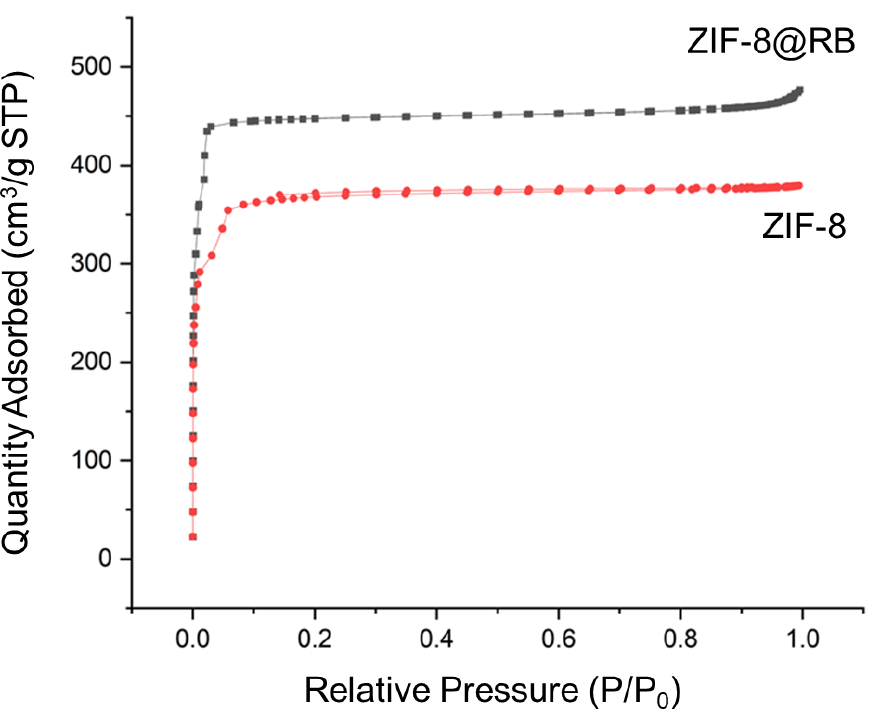
Figure 5. Nitrogen adsorption–desorption isotherms of ZIF-8 and ZIF-8@RB. 3.3. UV-Vis Spectrophotometry Monitoring of ZIF-8@RB Stability in Different Media